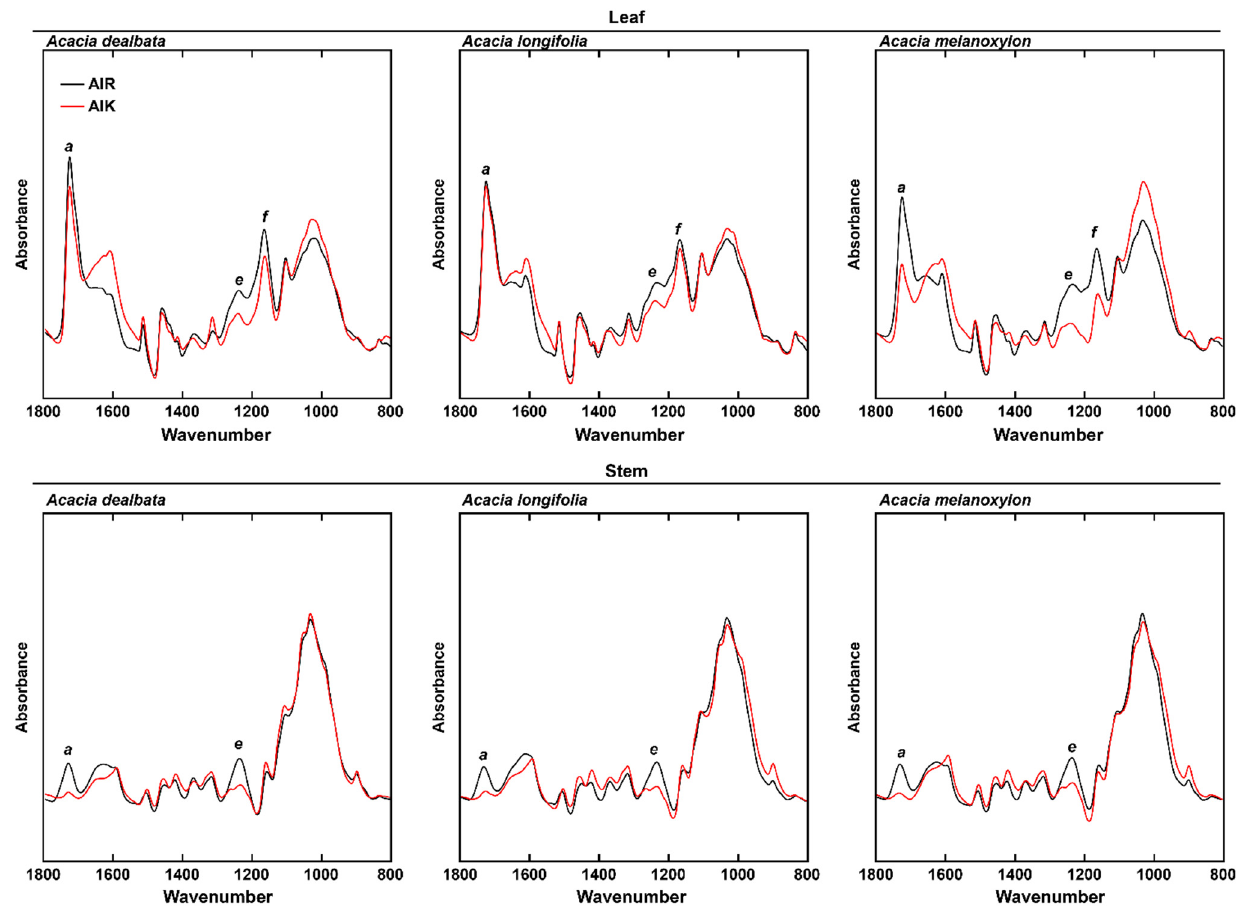
Figure 2. Mean FTIR-ATR spectra of non-pretreated alcohol insoluble residue (AIR) and mild alkali-pretreated alcohol insoluble residue (AIK) Acacia spp. biomass. Spectral bands: a , 1728 cm − 1 ; e , 1238 cm − 1 ; f , 1166 cm − 1 .